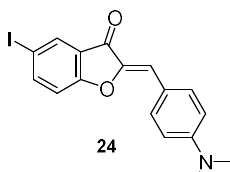
Figure 8. Synthetic aurone endowed with staining property.